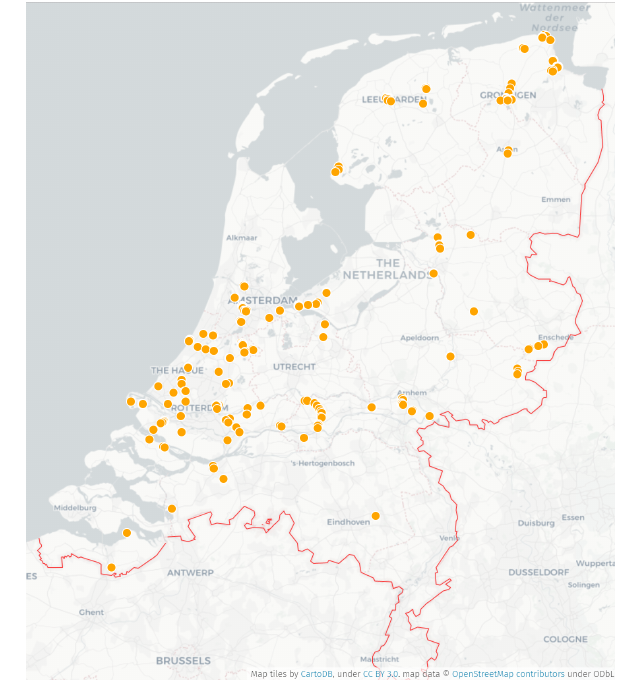
Figure 1. Borehole–CPT pairings across the Netherlands (©OpenStreetMap contributors YEAR. Distributed under a Cre- ative Commons BY-SA License, see https://www.openstreetmap. org/copyright, last access: 29 August 2019).